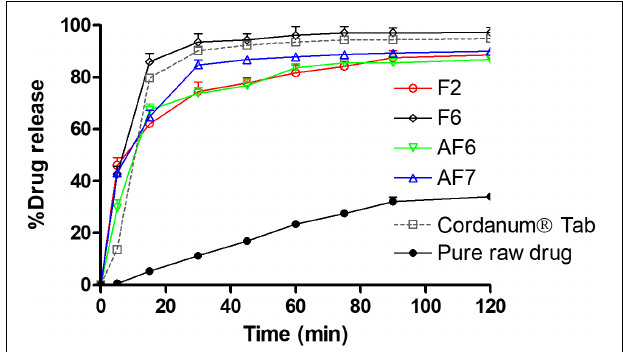
FIGURE 5 | In vitro release of TAL from the pure raw TAL powder, marketed product (Cordanum R (cid:13) ) and the representative self-nanoemulsifying TABLE 3 | The equilibrium solubility of TAL in various LFCS “Formulations” and formulations in acidic media (pH 1.2) at 37 ◦ C. The formulations represent (F2) “Alternative Formulations” at anhydrous and 99% dilutions. CoFA:I988(7:3)/TO106V(1/1), (F6) I308:TC(1:1)/HCO30(1/1), (AF6) CMCM:TC(1:1)/HCO30(1/1) and (AF7) TC. Data are represented as No. Composition Solubility (mg/g) mean ± SD, n = 3. Anhydrous 99% diluted formulation formulation